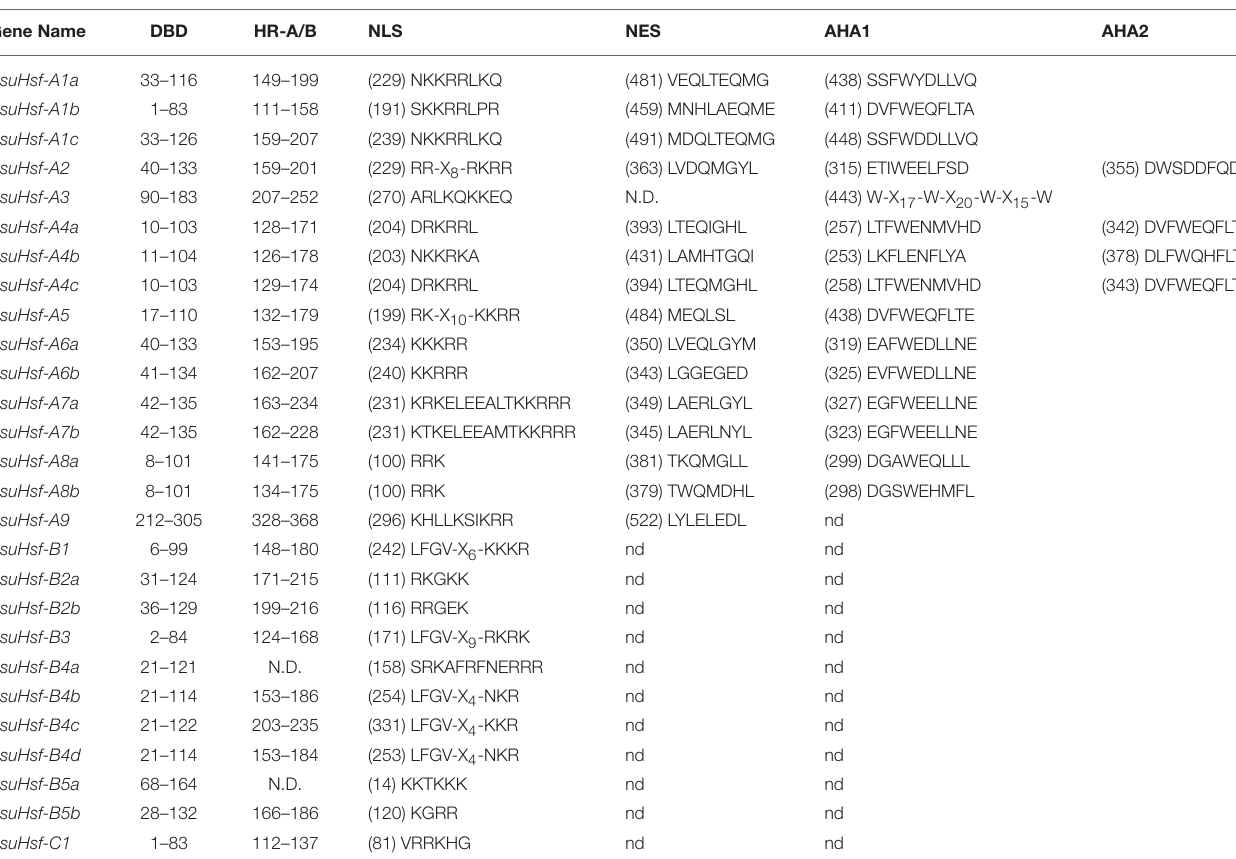
TABLE 4 | Functional domains of